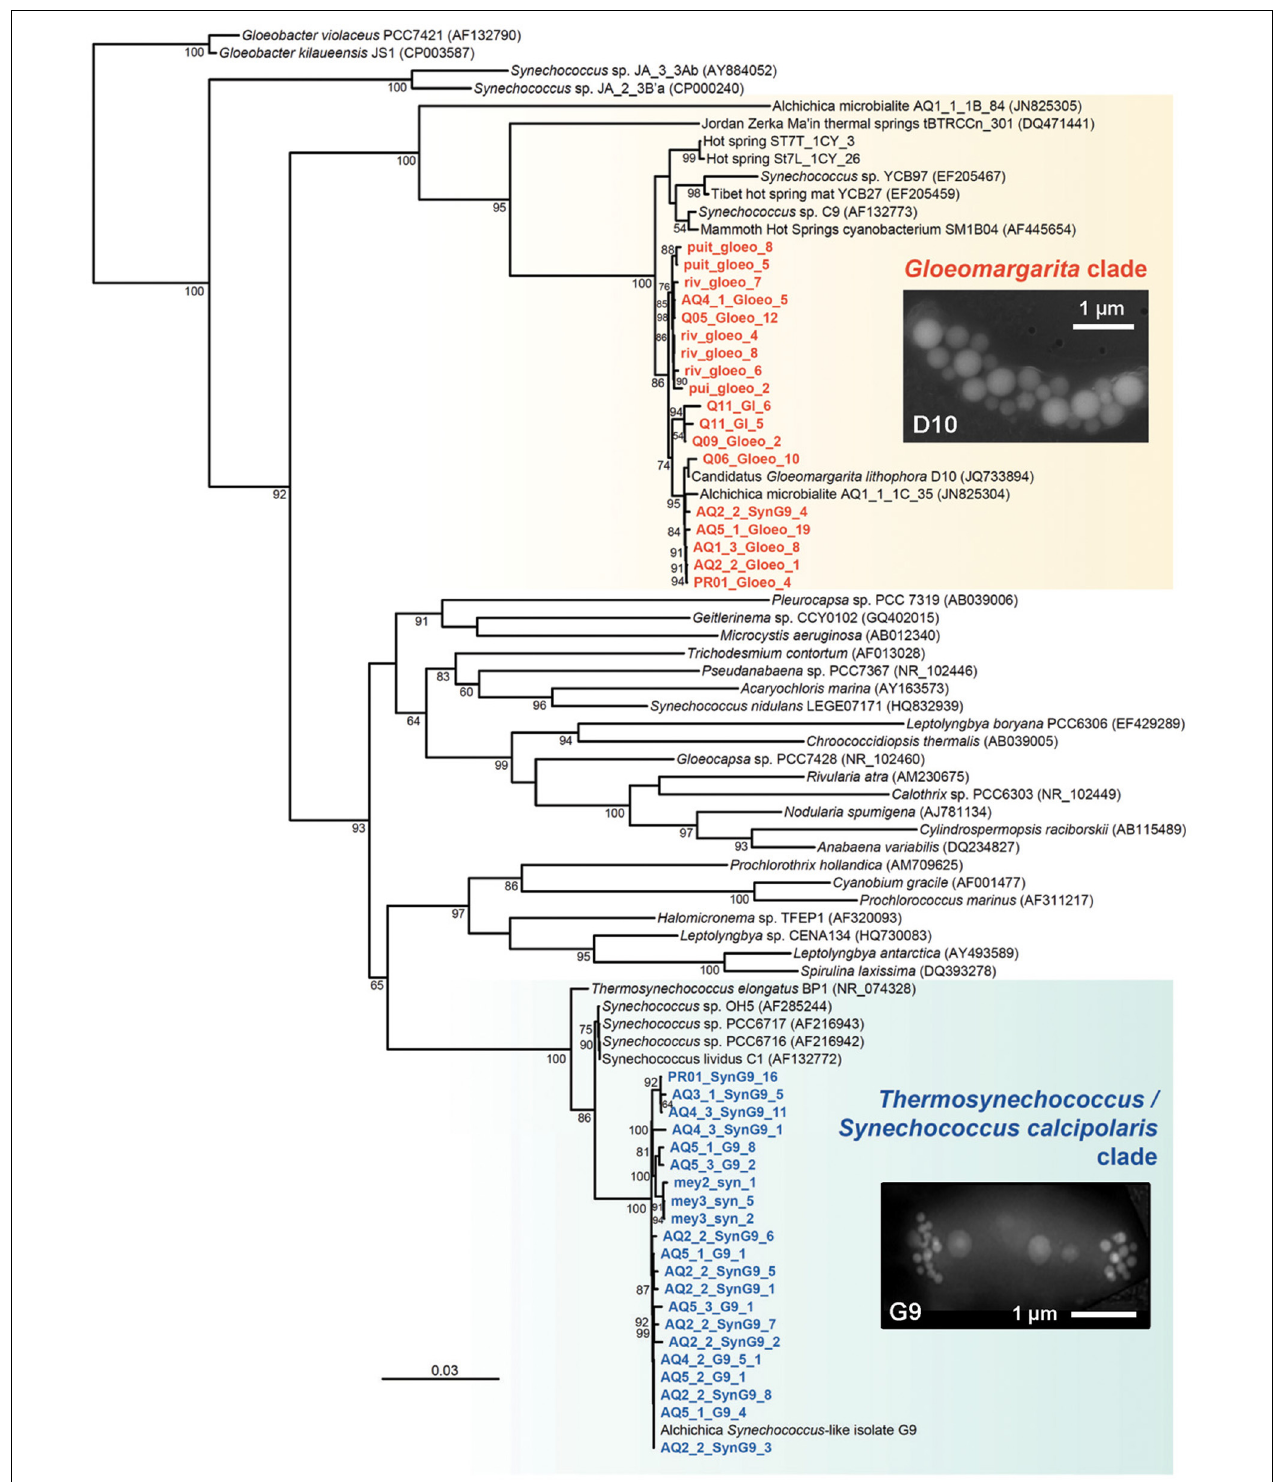
FIGURE 1 | Phylogenetic tree showing the diversity and the position of two lineages of cyanobacteria producing intracellular carbonate inclusions. Scanning microscopy photographs of inclusion-bearing cells belonging to representative strains of the Gloeomargarita and the Thermosynechococcus / S. calcipolaris clades are shown as insets. The tree